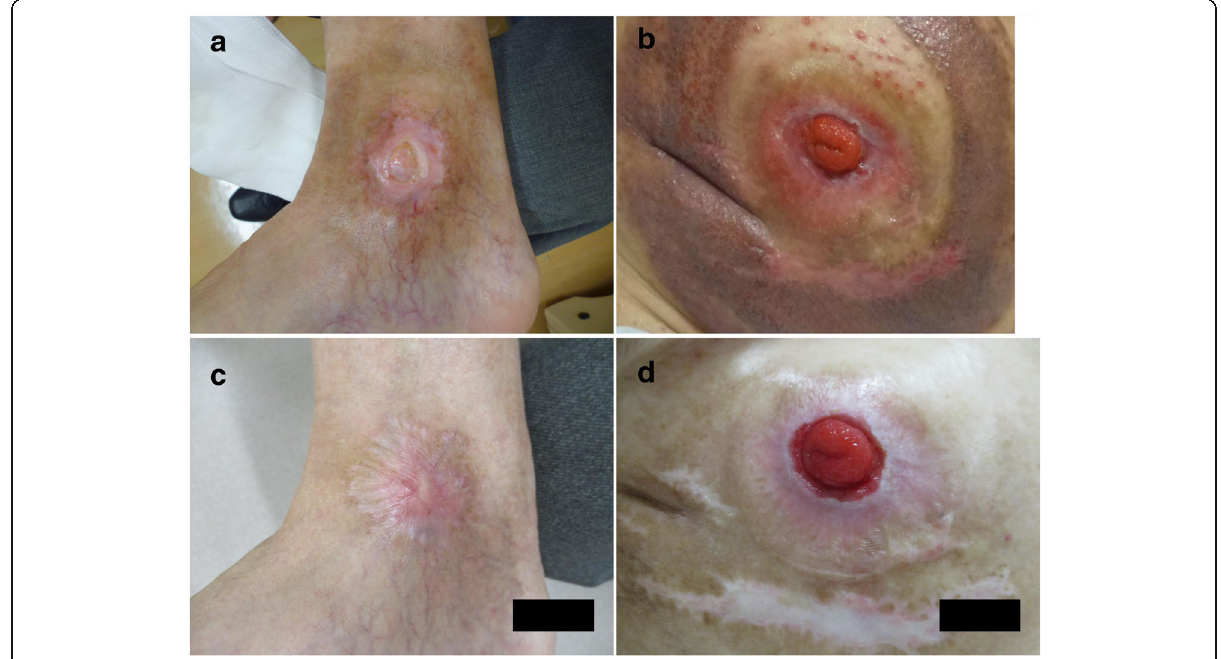
Fig. 4 The ulcer areas in the right ankle ( a ) and around the stoma ( b ) were significantly reduced and covered by the epithelium at 6 months after the last surgery. The ulcers were completely healed with some scar tissue in the right ankle ( c ) and around the stoma ( d ) at 3 years after the last